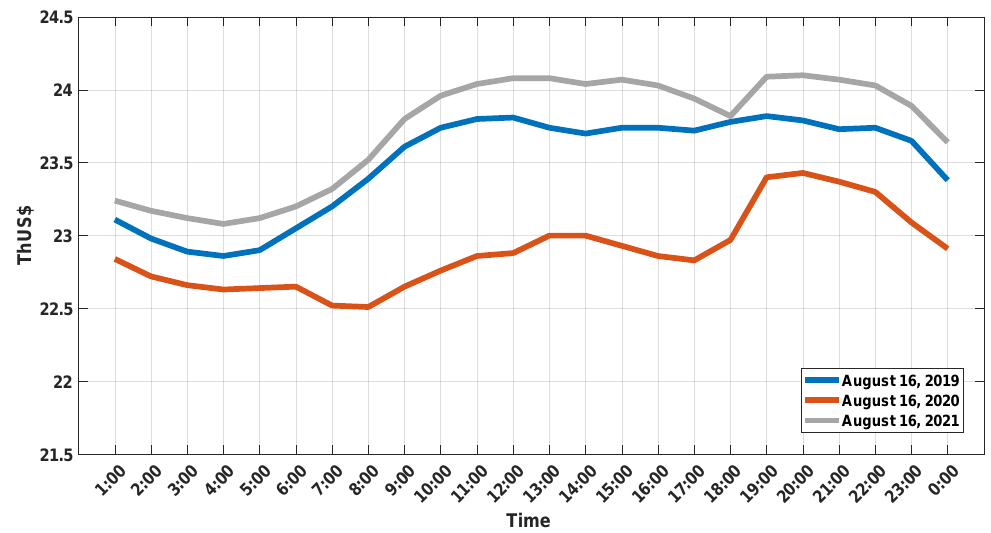
Figure 25. Optimal cost of ng consumption to cover electricity demand by stage.